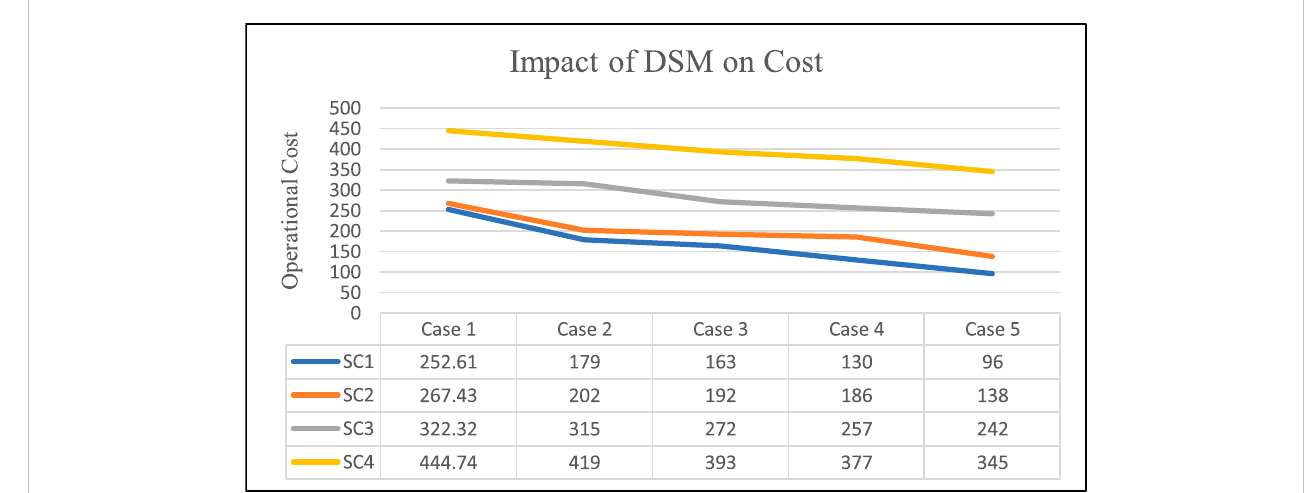
FIGURE 12 Impact of DSM and Scenarios on